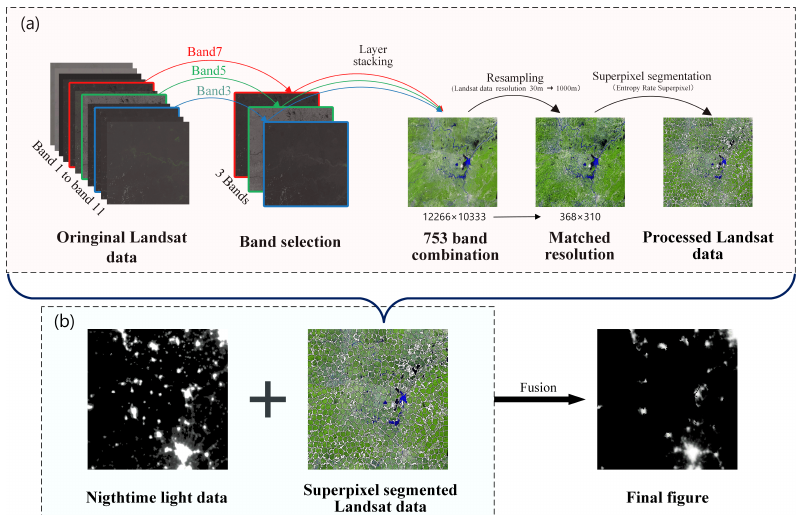
Figure 1. The flowchart of the proposed superpixel segmentation with assignment method. ( a ) Oringinal Landsant data, Band selectiion, 753 band combination, Matched resolution, Processed Landsat Data; ( b ) Nighttime light data, Superpixel segmented Landsat